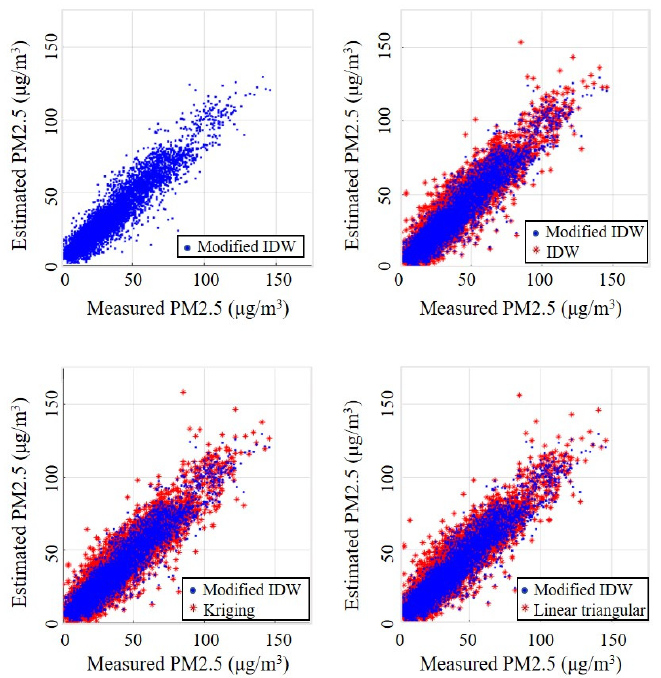
Figure 5. Comparison between estimated and observed PM2.5 values: ( a ) modified IDW, ( b ) IDW and modified IDW, ( c ) kriging and modified IDW, and ( d ) linear triangular and modified IDW.